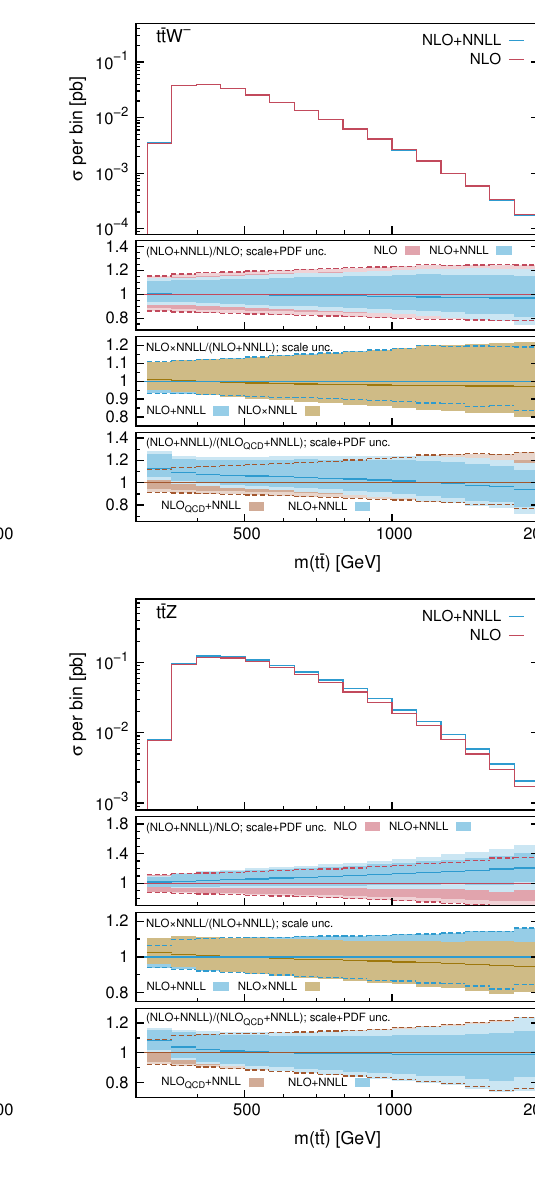
Figure 3 . Distributions di(cid:11)erential w.r.t. the invariant mass of the top-quark pair. Same structure as in (cid:12)gure